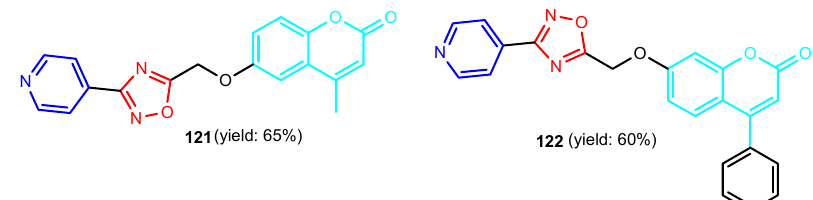
Figure 12. Structure of 1,2,4-oxadiazol-coumarin-pyridines 121 and 122 .